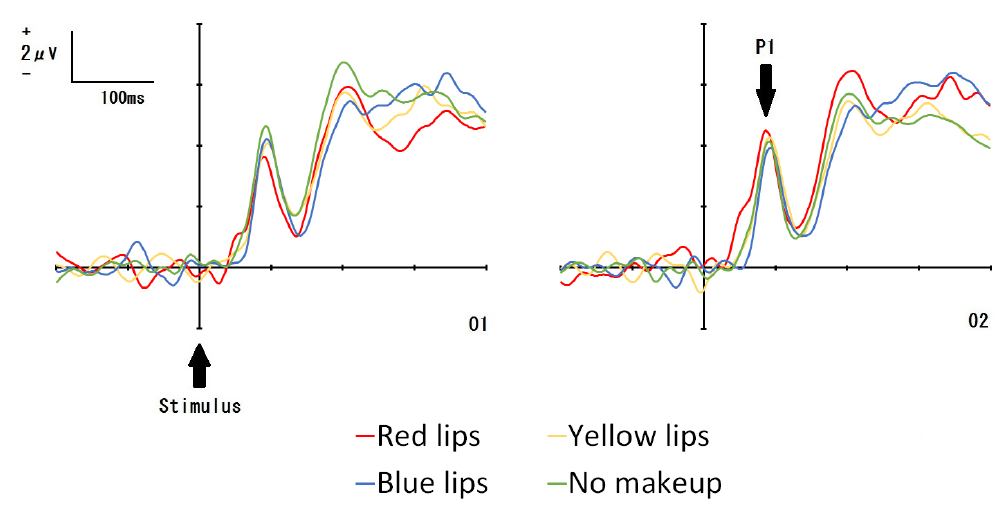
Table 1. Mean attractiveness scores and mean reaction times (ms) for the four lip conditions. Red lips Yellow lips Blue lips No-makeup Mean SD Mean SD Mean SD Mean SD Attractiveness scores 3.24 0.64 1.65 0.50 1.46 0.52 2.78 0.64 Reaction times 348.12 68.54 345.01 58.15 360.83 76.01 376.11